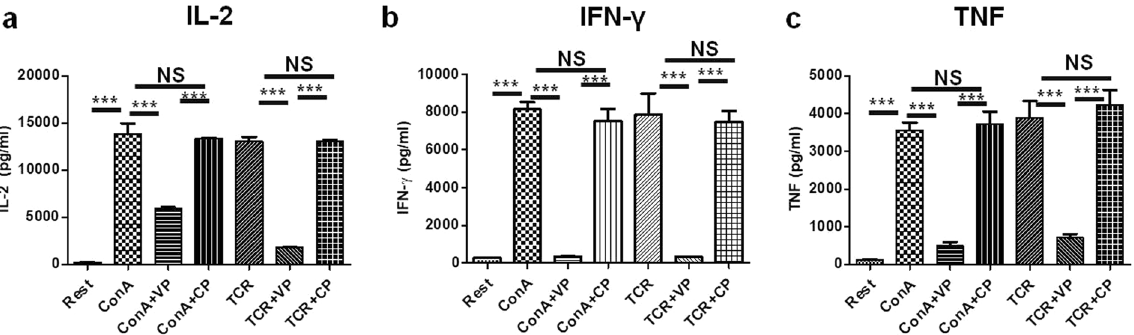
Figure 4. VIPER suppress T cell effector cytokine response. Cytokine ELISA data in pg/ml for IL-2 ( a ), IFN- γ ( b ) and TNF ( c ) shows VIPER treated T cells produce less inflammatory cytokines as compared to cells treated with ConA, TCR or with Control Peptide. Data shown are representative of three independent experiments and Bars represent the mean ± SEM. * p < 0.05, ** p < 0.01, *** p < 0.001.